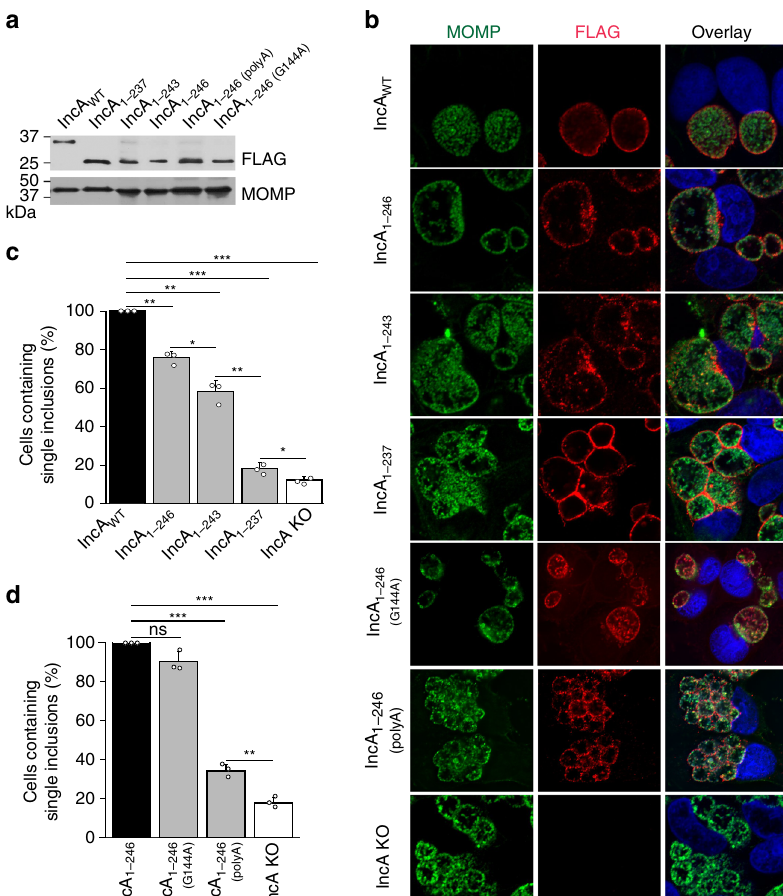
Fig. 4 The intramolecular interactions in IncA 87 – 246 are critical for its fusogenic activity. a IncA mutant -FLAG complemented-IncA KO strains express comparable amounts of IncA mutant -FLAG protein (Supplementary Fig. 10). HeLa cells were infected with the indicated strains for 24 h and then lysed in sample buffer. Samples were analyzed by western blot using anti-FLAG and anti-MOMP primary antibodies. C. trachomatis MOMP served as a loading control for infection. b Immuno fl uorescence microscopy analysis of HeLa cells infected with the indicated IncA mutant -FLAG complemented IncA KO strain at 24 hpi. Bacteria were labeled with anti-MOMP (green) antibody and the expression of IncA mutant -FLAG on the inclusion was revealed with anti-FLAG (red) antibody. DNA was stained with Hoechst (blue). The ring-like FLAG staining (red) shows that the IncA mutant -FLAG constructs are secreted onto the inclusion surface, indicating that any loss of fusogenic function is not due to their mislocalization. Scale bar = 10 µ m. Images are representative of three independent experiments. c and d Quanti fi cation of homotypic fusion with the indicated IncA mutant -FLAG complemented IncA KO strain. Data were normalized to IncA WT -FLAG ( c ) or IncA 1 – 246 -FLAG ( d ) Chlamydia . IncA KO Chlamydia served as a negative control. Graphs display the means of three independent experiments ± the standard deviation. Asterisks indicate statistical signi fi cance where, * denotes p -values < 0.05, **denotes p -values < 0.01, and *** denotes p -values < 0.001 (two-tailed student t -test). Source data are provided as a Source Data fi